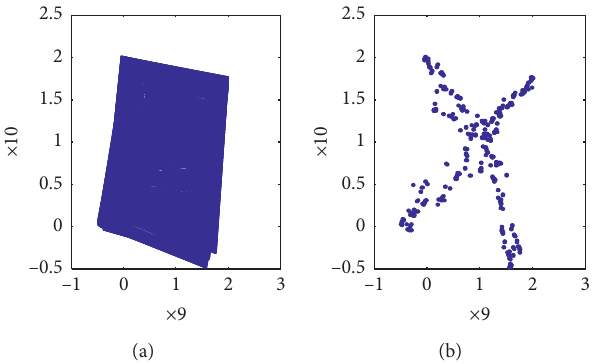
Figure 17: ω � 214 and k � 0 . 248without random perturbation. w (a) Phase trajectories, (b) Poincare maps.